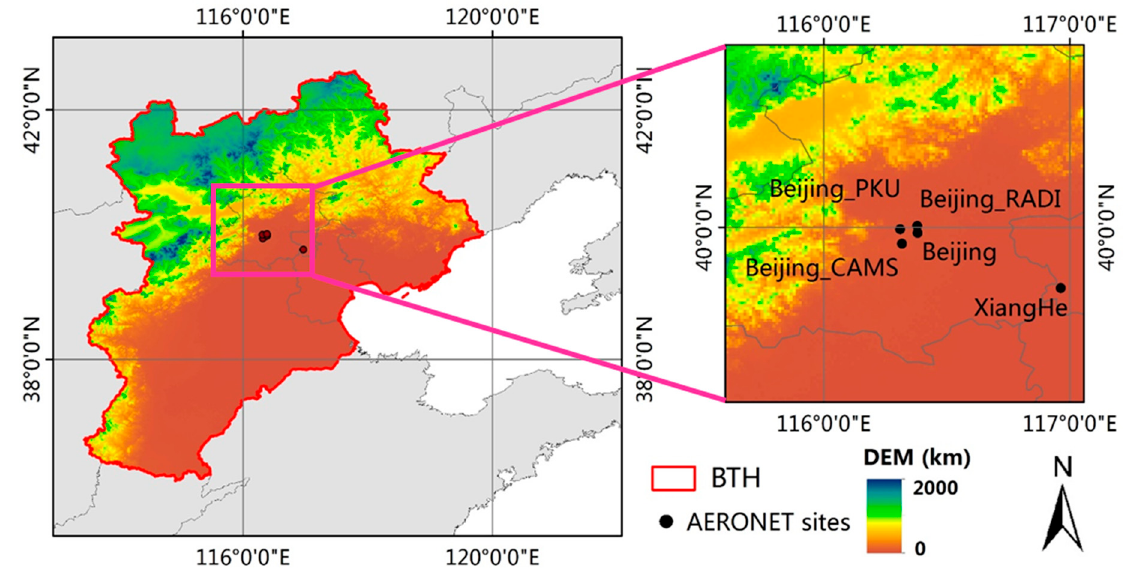
Figure 1. Locations of AERONET ground ‐ based sites over Beijing–Tianjin–Hebei (BTH) region. Elevation data obtained from the Advanced Spaceborne Thermal Emission and Reflection Radiometer Global Digital Elevation Model (GDEM) at 30 m spatial resolution.